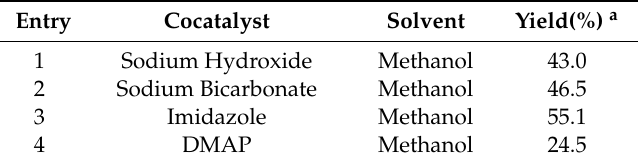
Table 4. Screening optimal PPL loading with different cocatalyst and solvents.